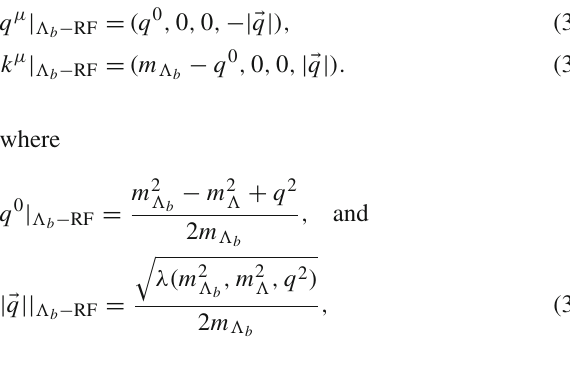
Table 6 Correlation matrix for the (cid:2) b → (cid:2)μ − e +